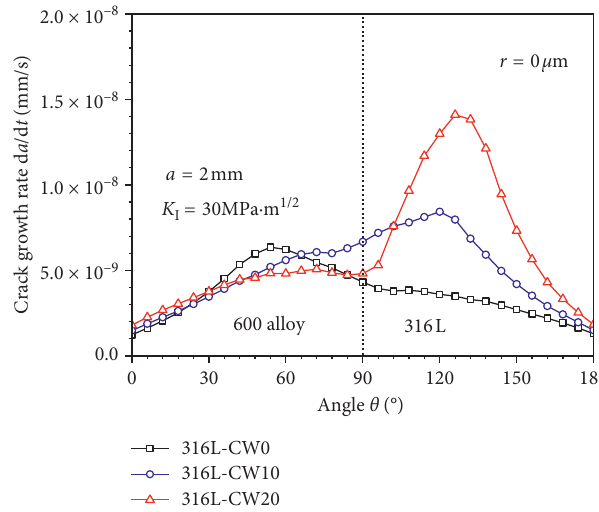
Figure 10: Effect of cold working on the creep rate.